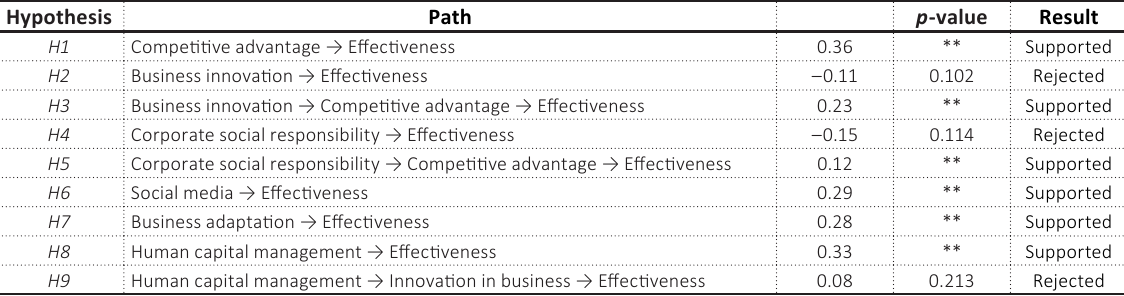
Table 4. SEM results for testing the